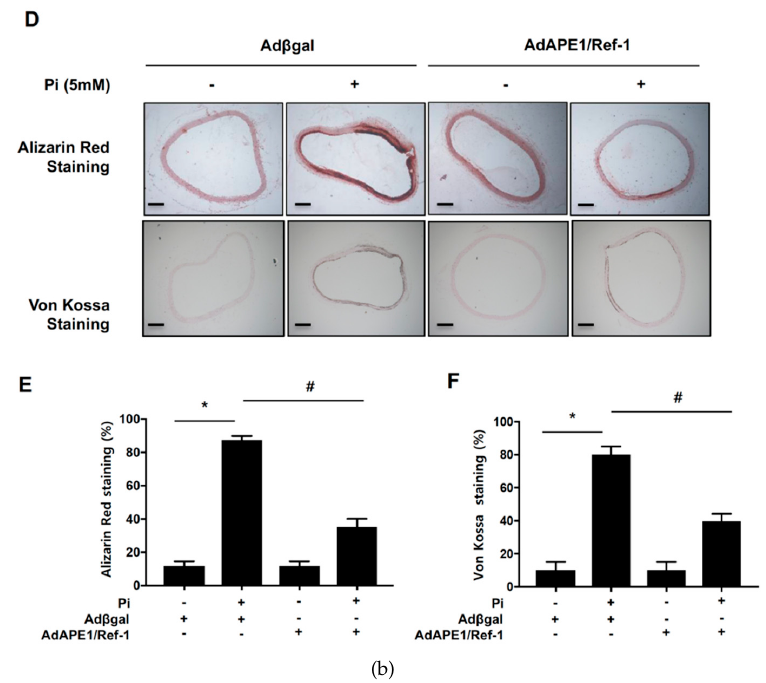
Figure 2. APE1/Ref-1 overexpression inhibited inorganic phosphate (Pi)-induced vascular calcification in vascular smooth muscle cells (VSMCs) ( A – C ) and ex vivo aorta ( D – F ). ( A ) Representative Western blot for APE1/Ref-1. After adenoviral APE1/Ref-1 infection at 90% confluency for 24 h, VSMCs were treated with Pi (5 mM) for 6 days. ( B ) Representative images (top) and quantification of alizarin red staining. At the end of incubation, cells were stained with 2% alizarin red S. Each bar represents the mean ± standard error of the mean (SEM) ( n = 3). * p < 0.05 vs. control; # p < 0.05 vs. Pi alone by one-way ANOVA. ( C ) Calcium-deposition assay using the same conditions as described in ( B ). To evaluate calcium deposition, cells were decalcified by incubation for 24 h with 0.6 N HCl. Calcium content in the supernatant was determined colourimetrically using O -cresolphthalein and normalized to the protein concentration as described in the Materials and Methods. Each bar represents the mean ± SEM ( n = 5). * p < 0.05 vs. control; # p < 0.05 vs. Pi alone by one-way ANOVA. ( D – F ) APE1/Ref-1 overexpression inhibited Pi (5 mM)-induced aortic vascular calcification ex vivo. After adenoviral APE1/Ref-1 (10 9 plaque-forming units in 2% Dulbecco’s modified Eagle medium) transfection, aortic tissues without the endothelium were treated with Pi (5 mM) for 6 days. Calcification of aortic tissue was assayed by alizarin red staining and von Kossa staining. ( D ) Representative data of aortic calcification. Quantitative analysis of alizarin red staining ( E ) and von Kossa staining ( F ). Each bar represents the mean ± SEM ( n = 4). * p < 0.05 vs. control; # p < 0.05 vs. Pi alone by one-way ANOVA. Microscopes at 40× magnification were used for visualization. Scale bar: 100 μ m.